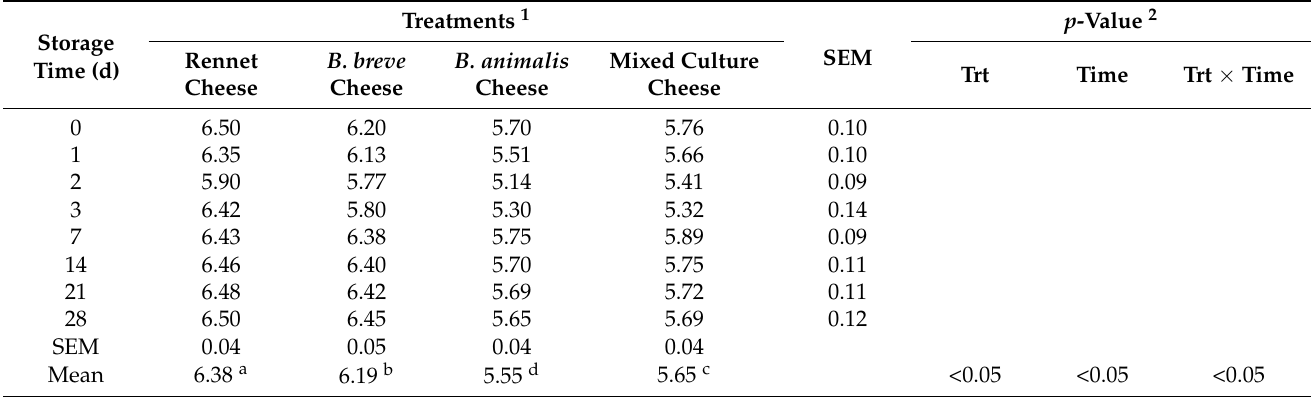
Table 5. The pH of manufactured soft cheese with Bifidobacterium spp. stored at 4 ± 2 ◦ C.